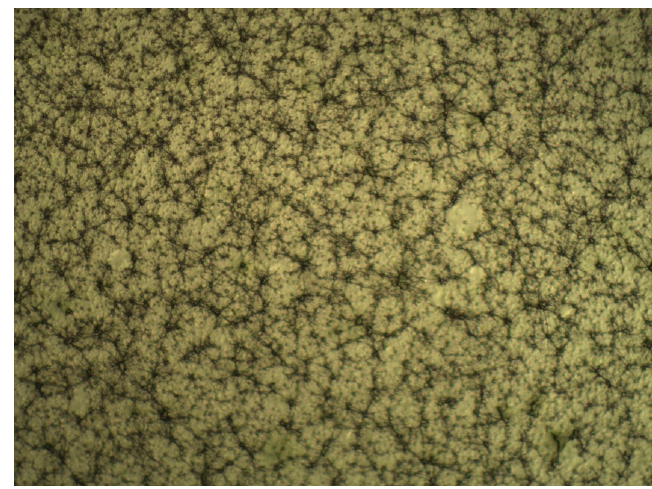
Figure 7. Optical microscope image of the electrospun 100% ethanol extracts. 100× amplification.